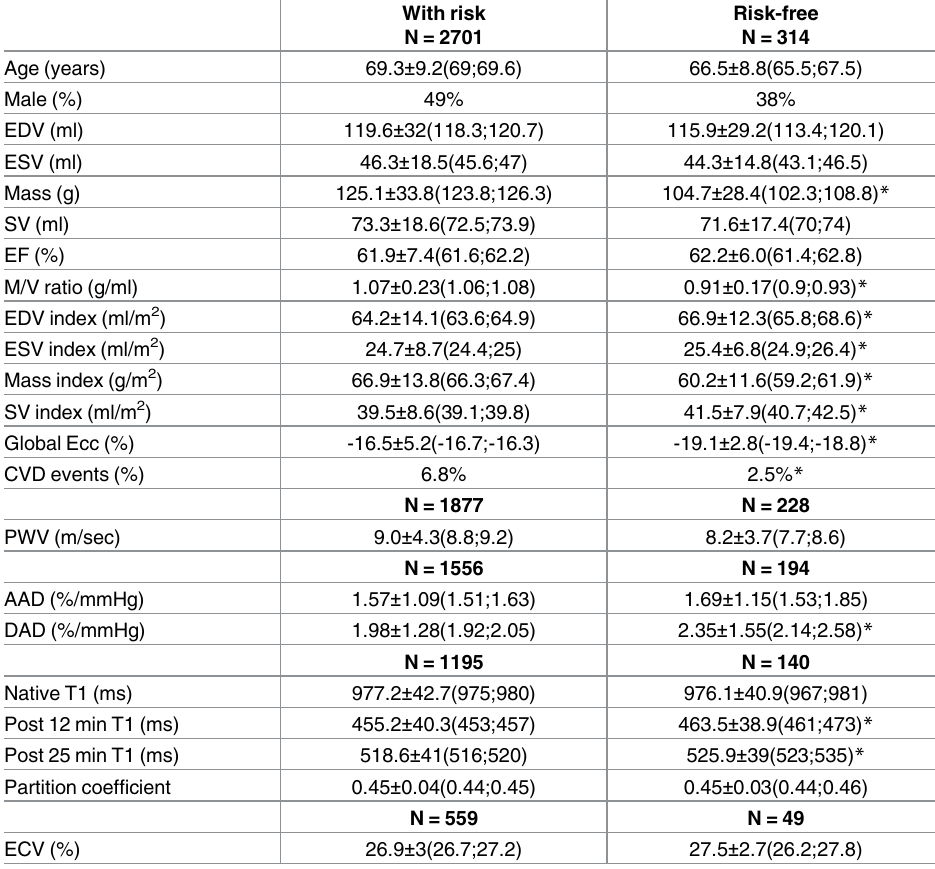
Table 1. Left-ventricular (LV) structure/function and aortic function of risk-free and with risk MESA participants. Values displayedas mean ± SD(95% confidenceinterval) and * for p < 0.05betweengroups after multivariate adjustmentfor age/sex/race.